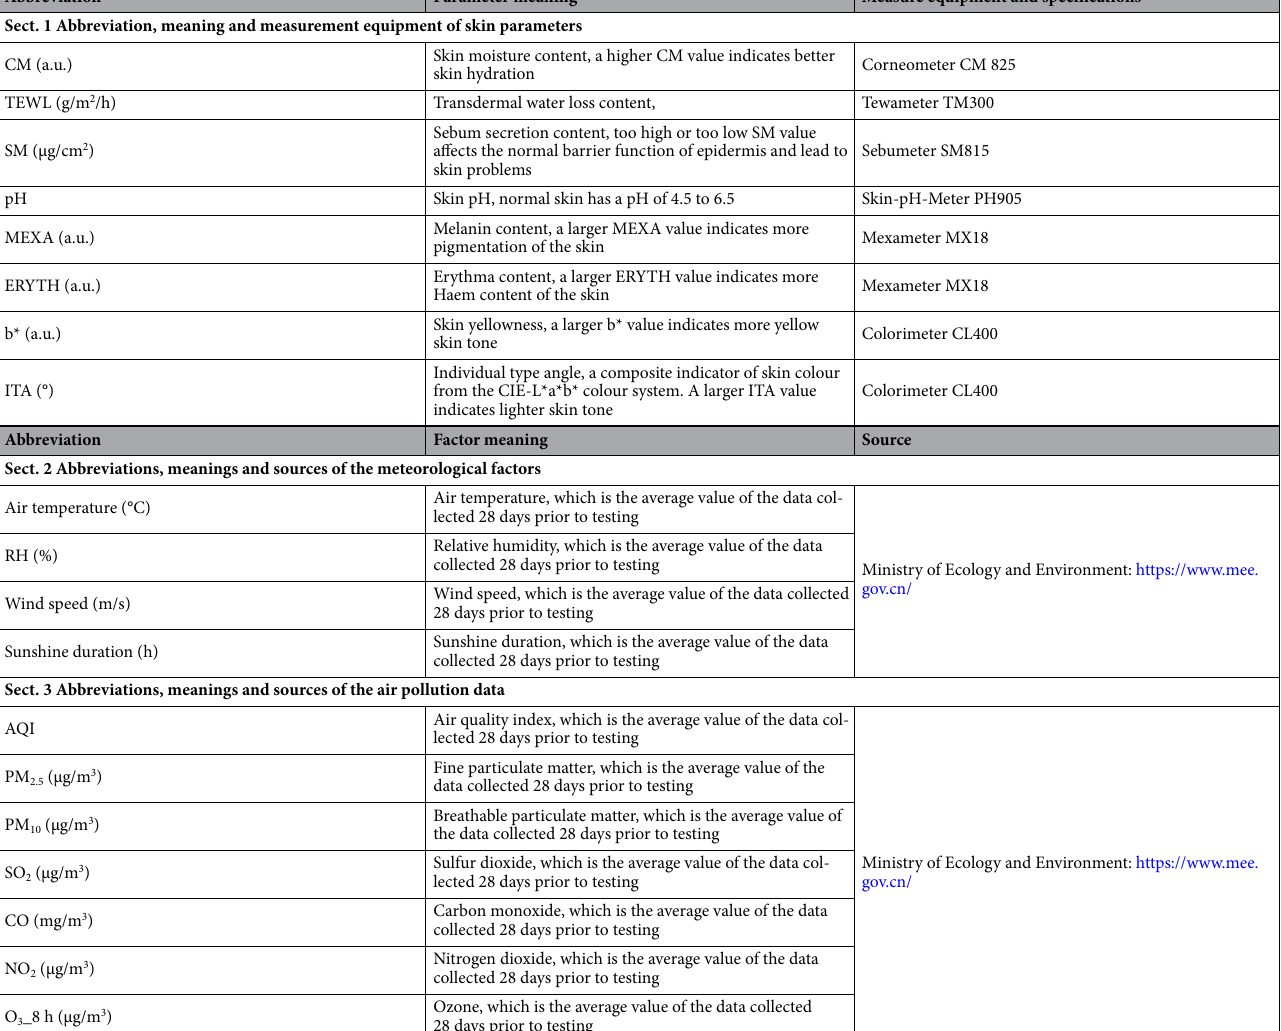
Table 1. Abbreviation, meaning and measurement equipment/sources of the